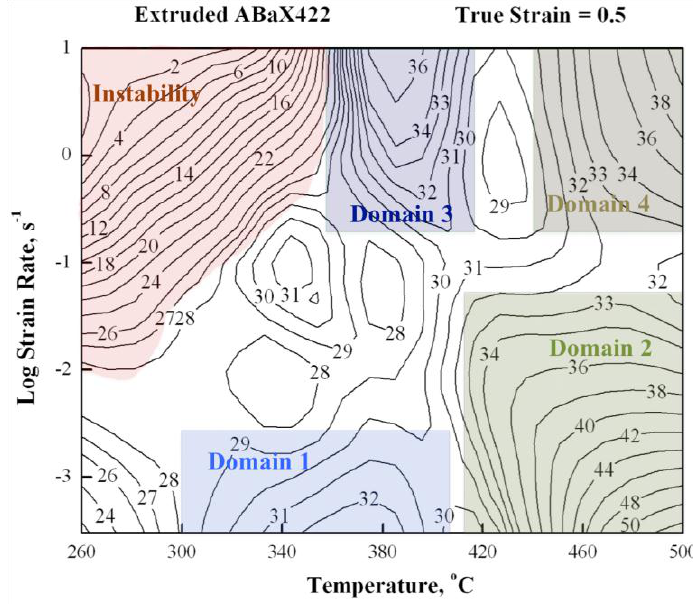
Figure 5. Processing map for the extruded ABaX422 alloy developed at a true strain of 0.5. The numbers shown with the contours represent dissipation efficiency in percent. The shaded reddish area represents the flow instability regime.